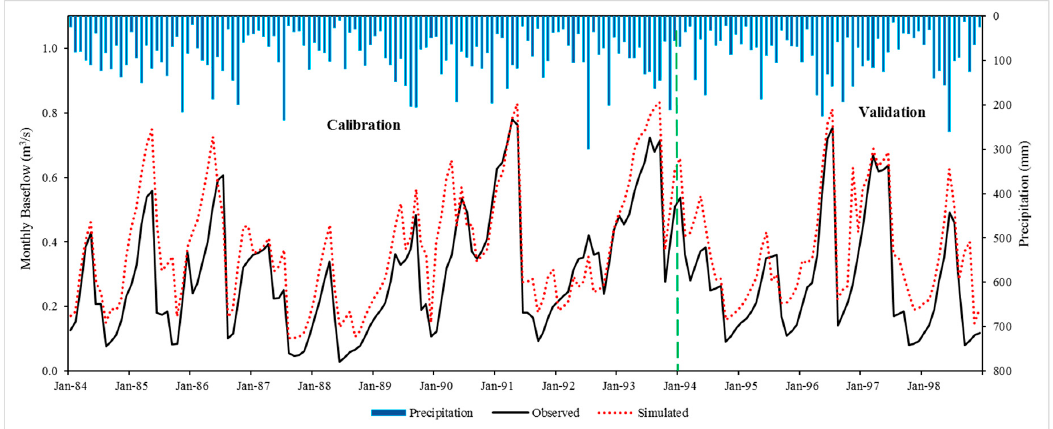
Figure 7. Observed and simulated baseflow of LEC watershed for calibration and validation period.